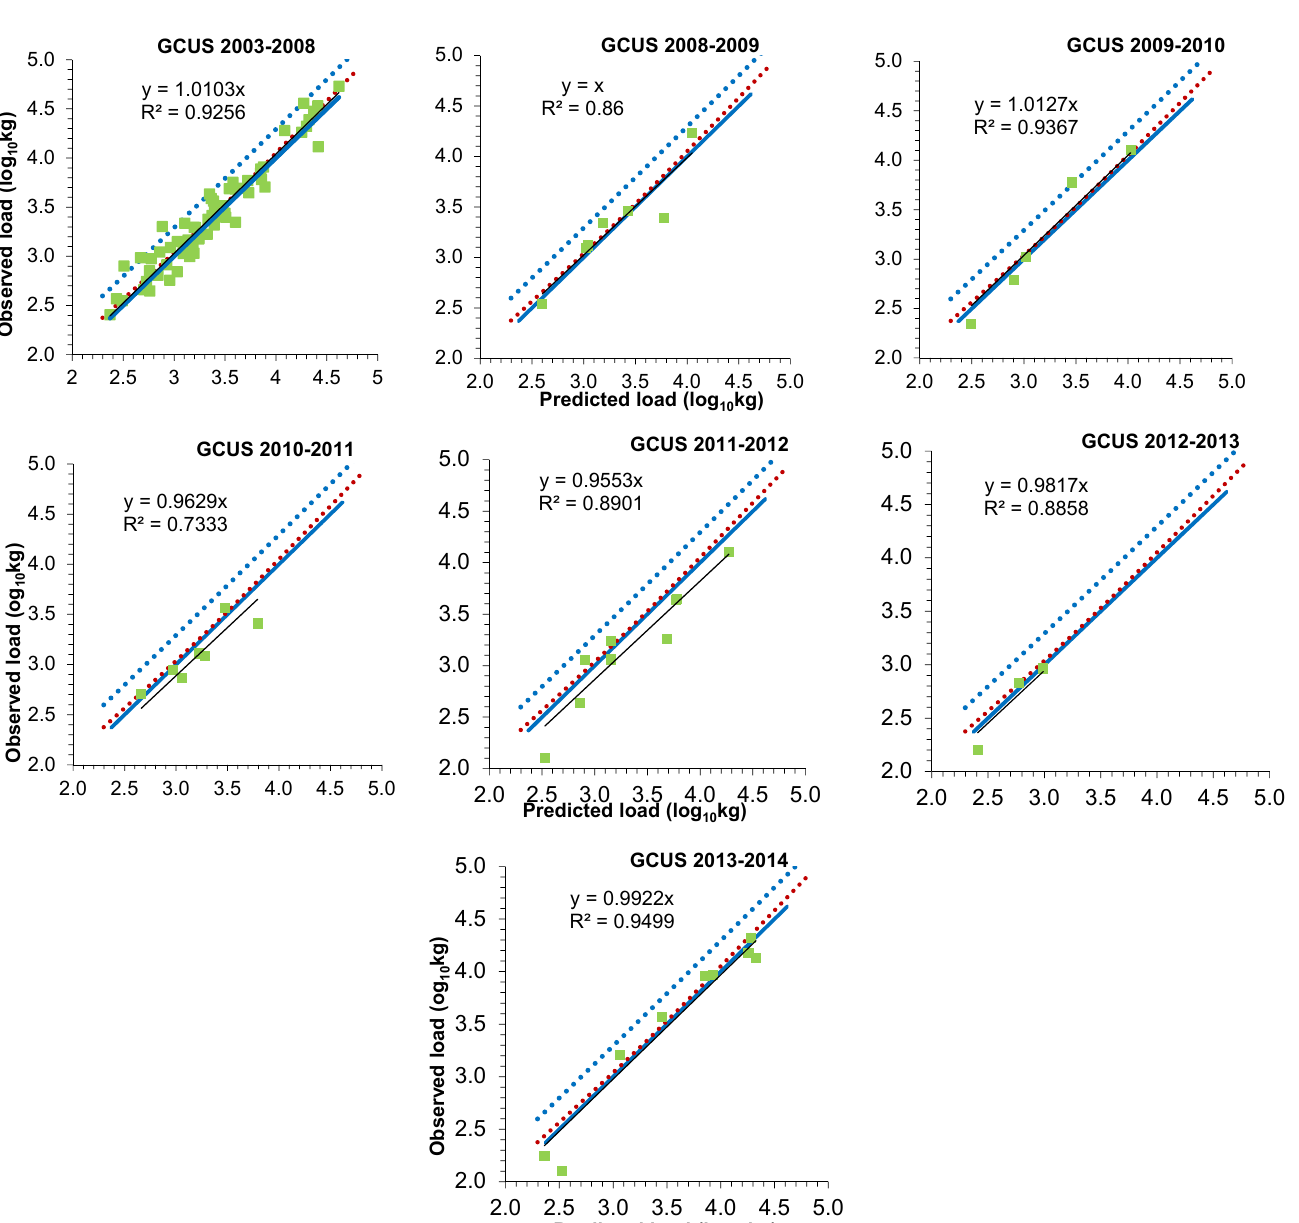
The dark blue line in each graph is the best fit (1:1) line for the undisturbed rela- tionship data. The red dashed line is the 95% confidence limit and the blue dashed line is the 95% prediction limit of the 1:1 line. The black line is the fitted line for the events in each year. Each event is shown as marker point in the graph. The markers are colored green when the events are evenly distributed around the best fit line (no disturbance in the catchment) and red otherwise.